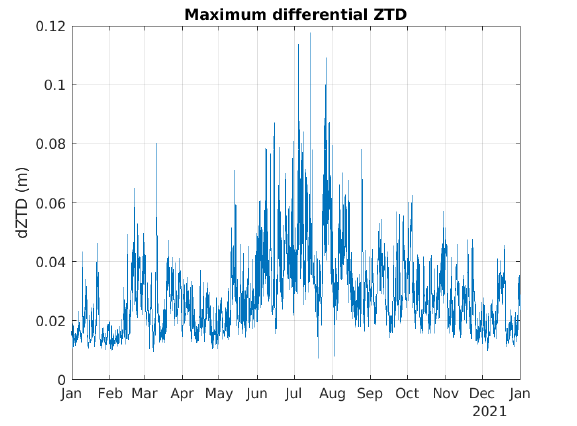
Figure 9. Estimated dZTD values for